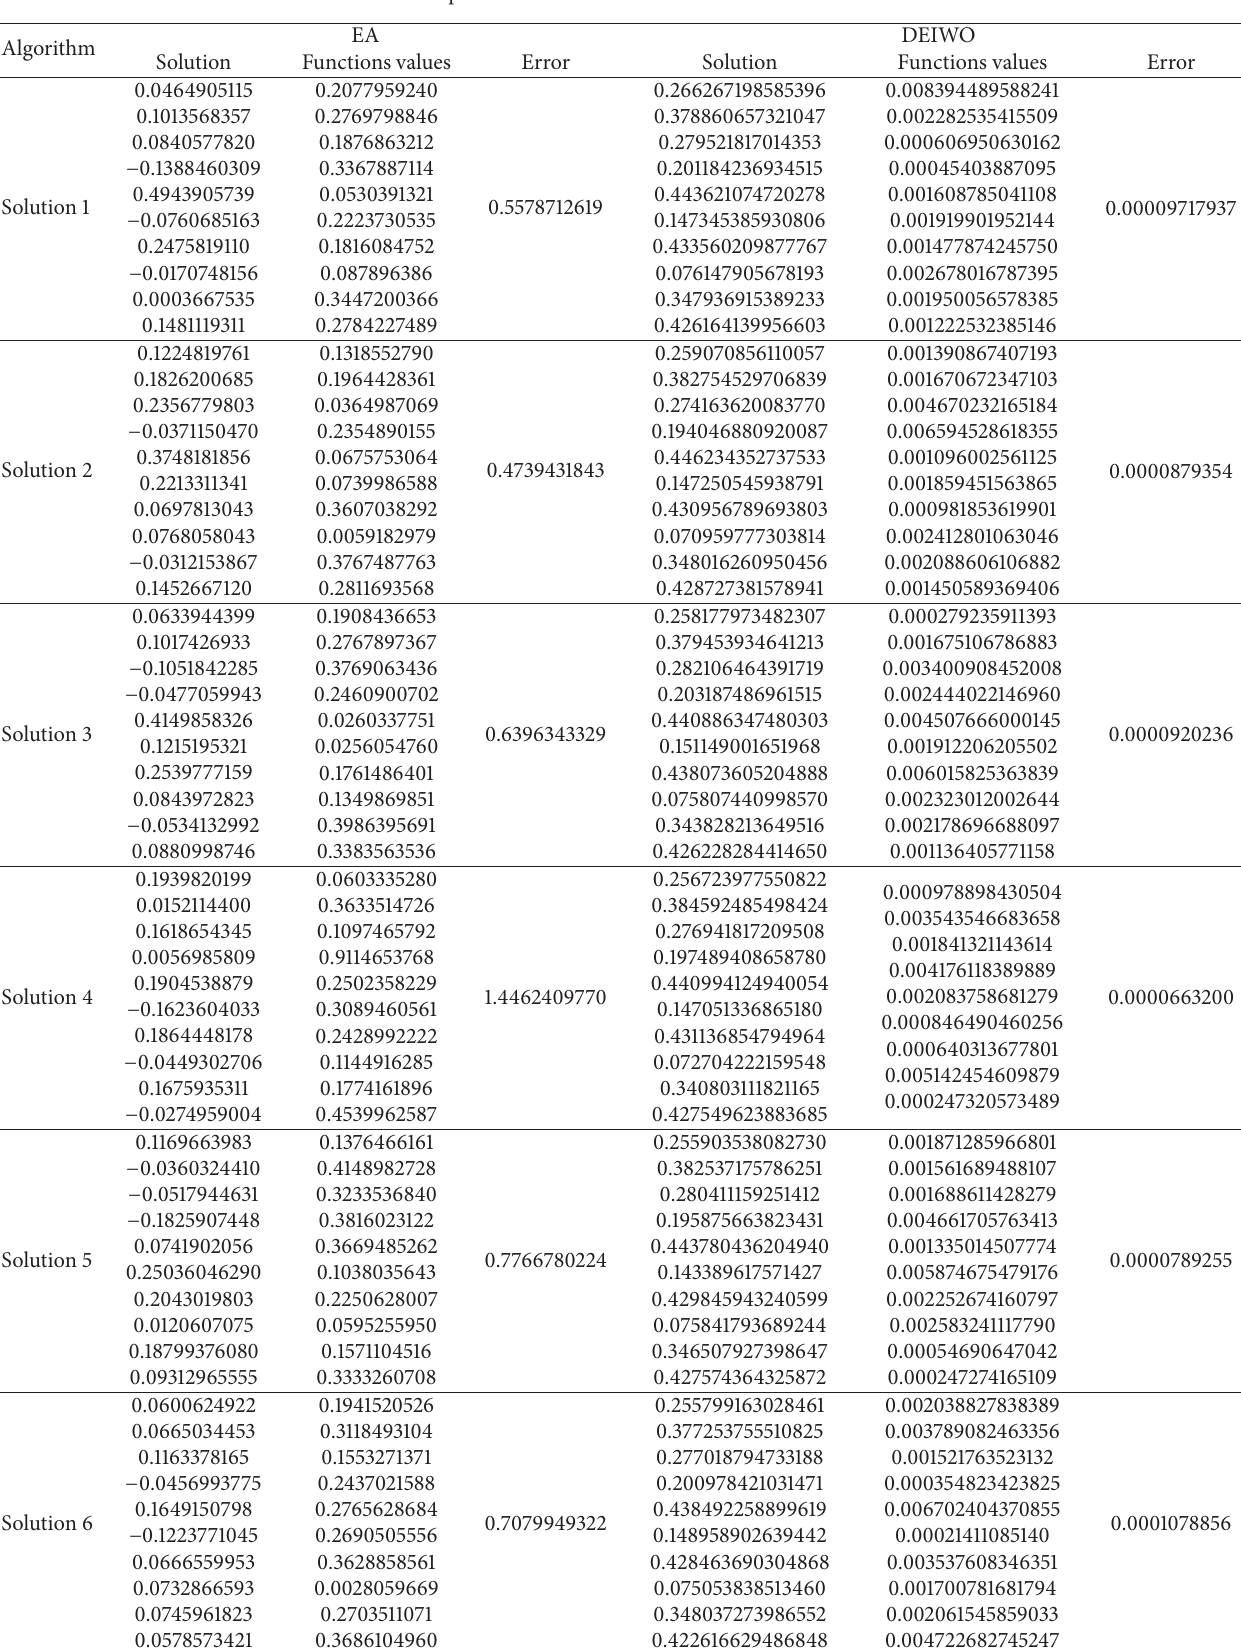
Table 6: Comparison of results for interval arithmetic